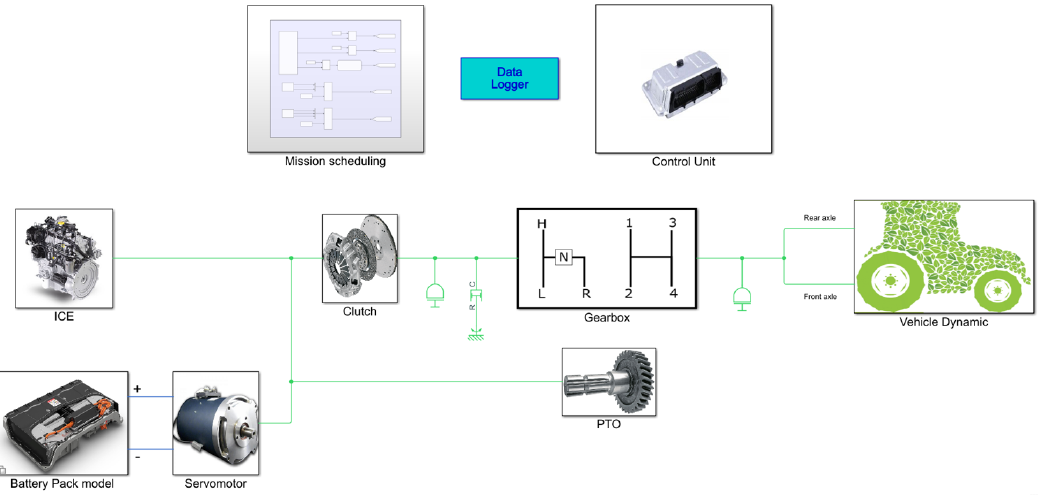
Figure 2. Tractor architecture